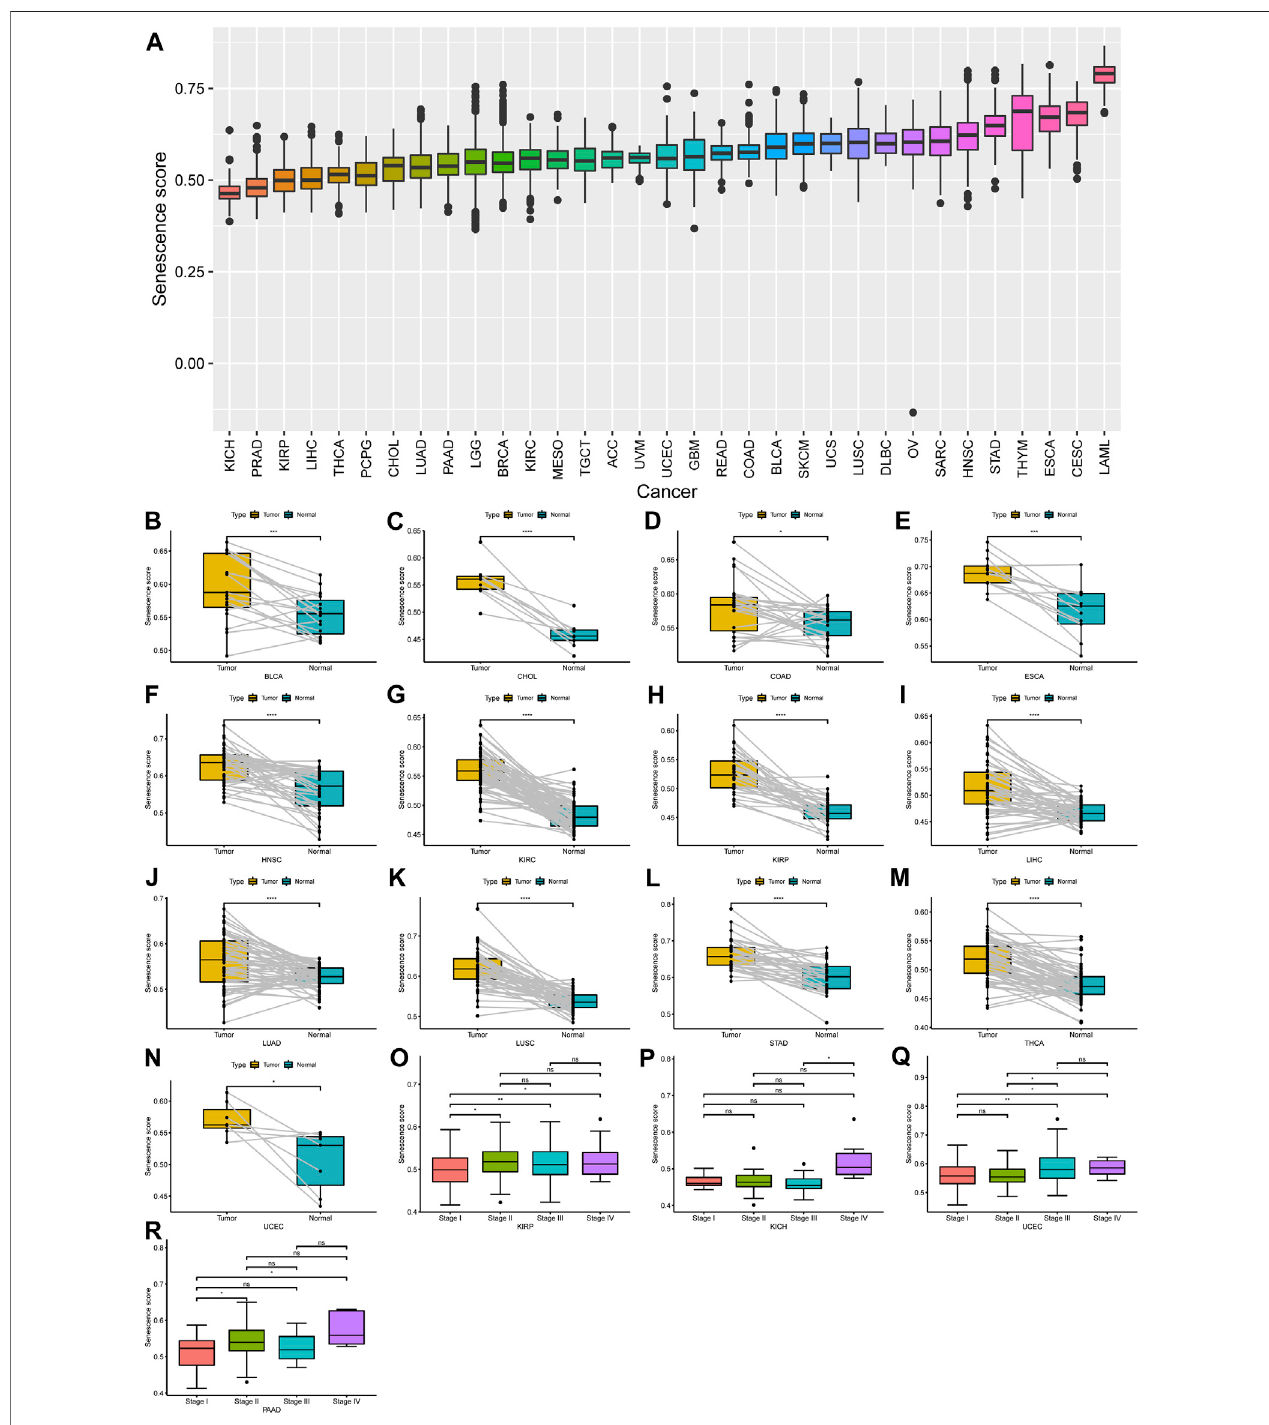
FIGURE 1 | Expression landscape of senescence-related genes (SRGs) in human cancer. (A) Spectra of senescence score (SS) across 33 different cancer types; 33 tumor types were ordered according to increasing SS from left to right. (B – N) A signi fi cant difference of SS was observed in 13 tumor types. (O – R) The SS was analyzed by the main pathological stages (stage I, stage II, stage III, and stage IV) in kidney renal papillary cell carcinoma, kidney chromophobe, uterine corpus endometrial carcinoma, and pancreatic adenocarcinoma. ( p < 0.05 was considered signi fi cant, * p < 0.05, ** p < 0.01, *** p < 0.001, and **** p < 0.0001).